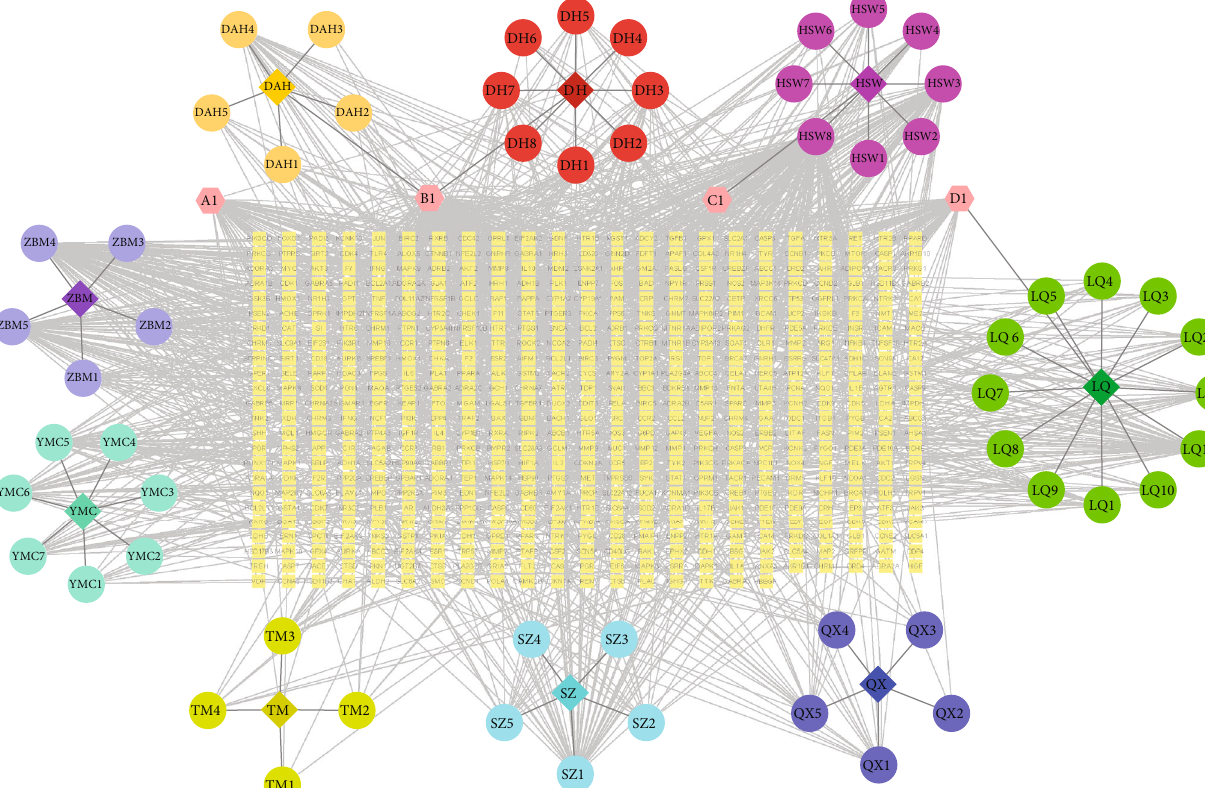
Figure 1: The ingredient-target network of BSYS Capsule. Diamond nodes represent the herbs, circle nodes represent the compounds, and square nodes represent the